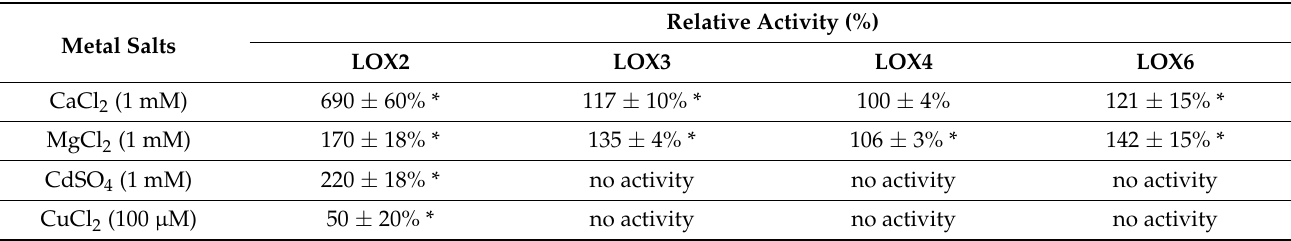
Figure 4. The 13-LOX mediated synthesis of 12-OPDA and OCPD. ( A ) Flow scheme for anticipated C18 and C22 CP synthesis from ω -3 PUFAs LeA and DHA, with 3-D models of LOX2 (based on SLOX, 4wfo), AOS (3dsk) and AOC (1z8k). ( B ) RP-HPLC analysis of 12-OPDA and ( C ) OCPD one-pot synthesis extracts, the peak of high intensity appearing at 7.4–7.5 min and 10.1 min corresponded to LeA- and DHA-derived 12-OPDA and OCPD, as revealed by a comparison with the retention times of standards. Table 2. Effect of divalent metals on 13-LOX